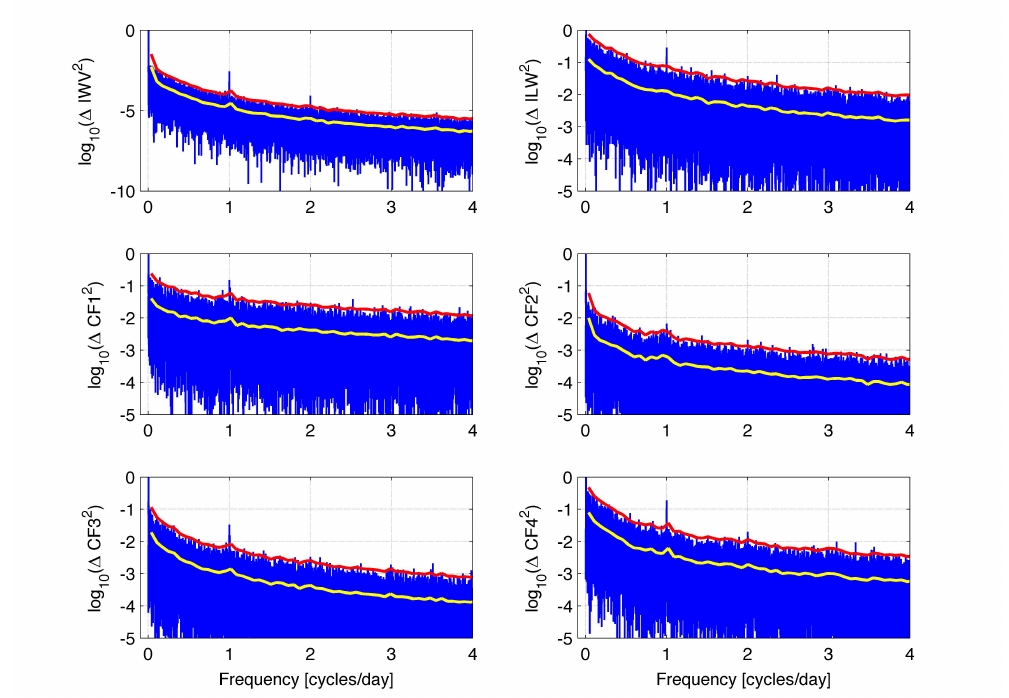
Figure 3. Fast Fourier Transform (FFT) power spectra (blue line) of the temporal fluctuations of IWV, ILW and CF in Bern for the time interval from 2004 to 2016. The spectra are normalized by the power of the maximum (power of the annual or semi-annual oscillation). The yellow line is the mean of the spectrum averaged over 1000 frequency grid points. The red line is the five sigma level of confidence. A significant diurnal cycle shows up as a blue spike at 1 cycle/day in each parameter. A significant semidiurnal cycle (at 2 cycles/day) is present for IWV and